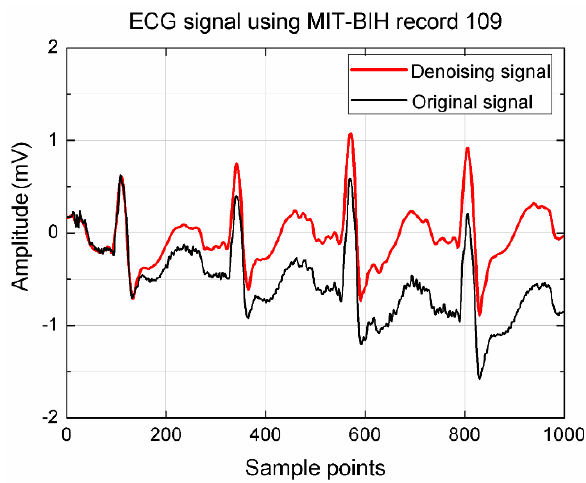
Figure 5. Comparison between the original signal and the de-noising signal.